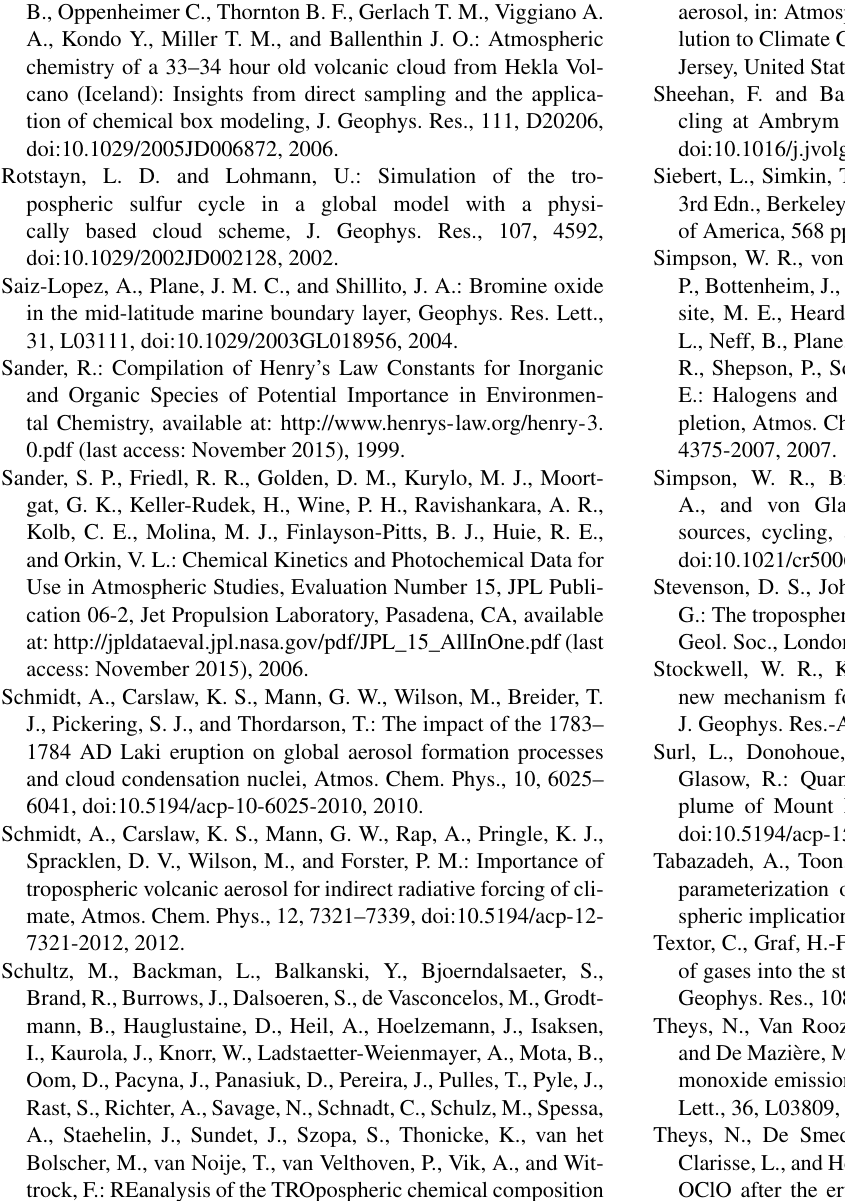
Tabazadeh, A., Toon, O. B., Clegg, S. L., and Hamill, P.: A